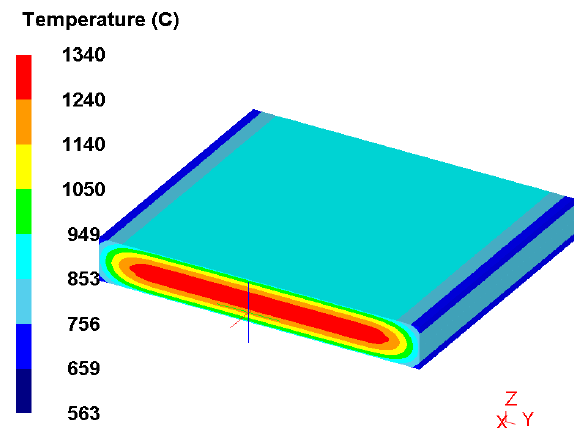
Figure 5. Temperature field of the slab at the mill entrance of HHR 2 .